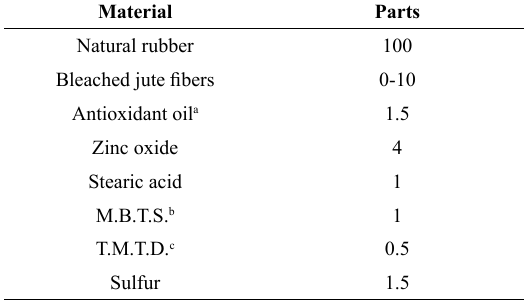
Table 1. Basic formulation of natural rubber